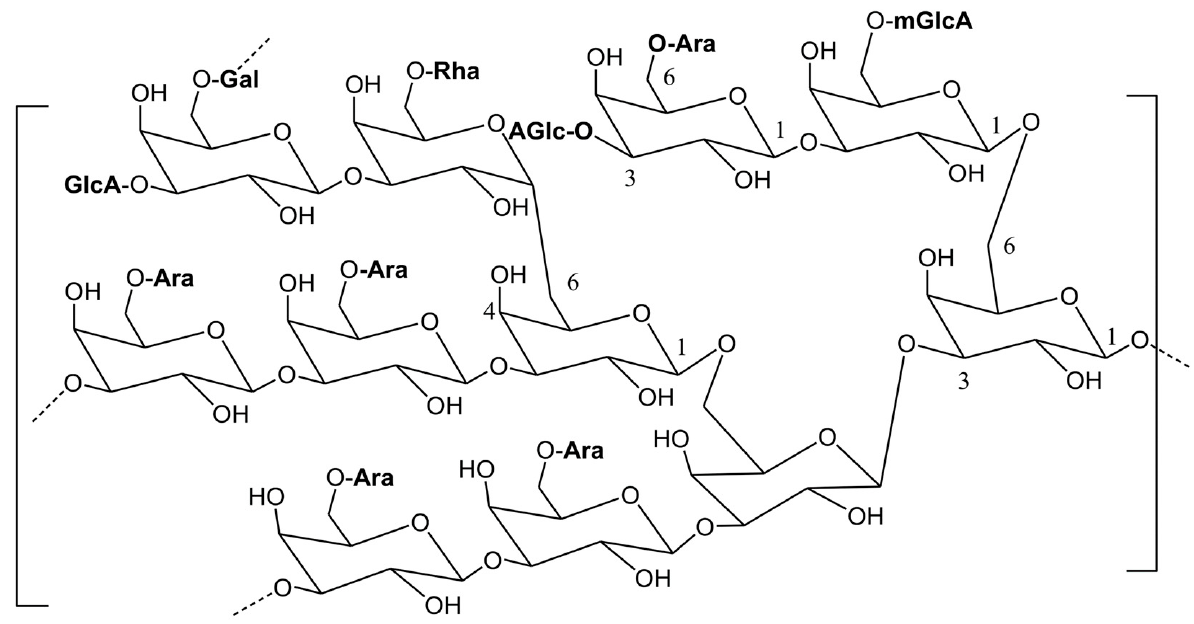
Figure 2. The basic chemical structure of arabic acid present in gum arabic [1].